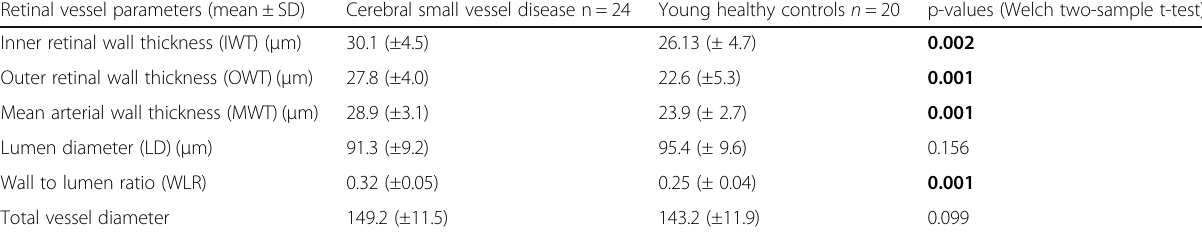
Table 2 Comparison between patients with cerebral small vessel disease and healthy controls Retinal vessel parameters (mean ±